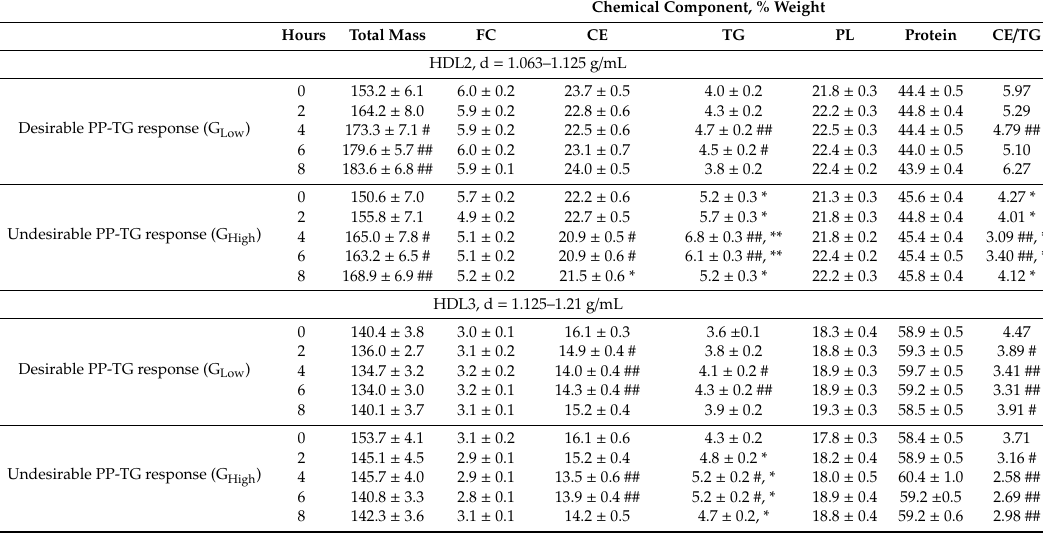
Table 3. Plasma levels and chemical composition of postprandial HDL subfractions in subjects with a desirable and an undesirable postprandial triglyceride